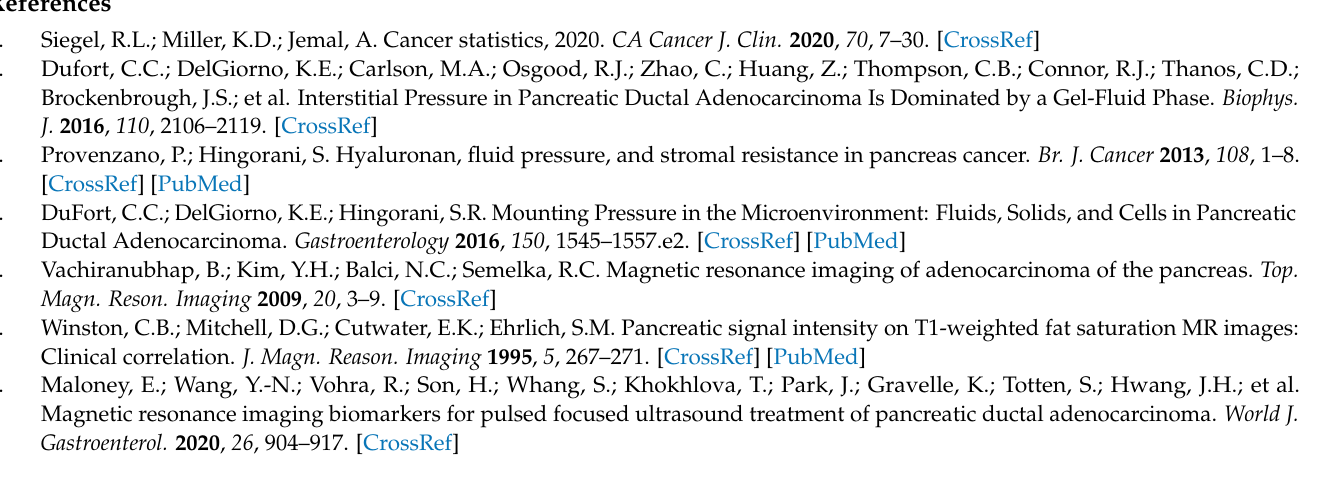
Figure S2: Representative image of methodology demonstrating the technique used to quantify connective tissue deposition in the region of interest in the pancreatic tumor of KPC